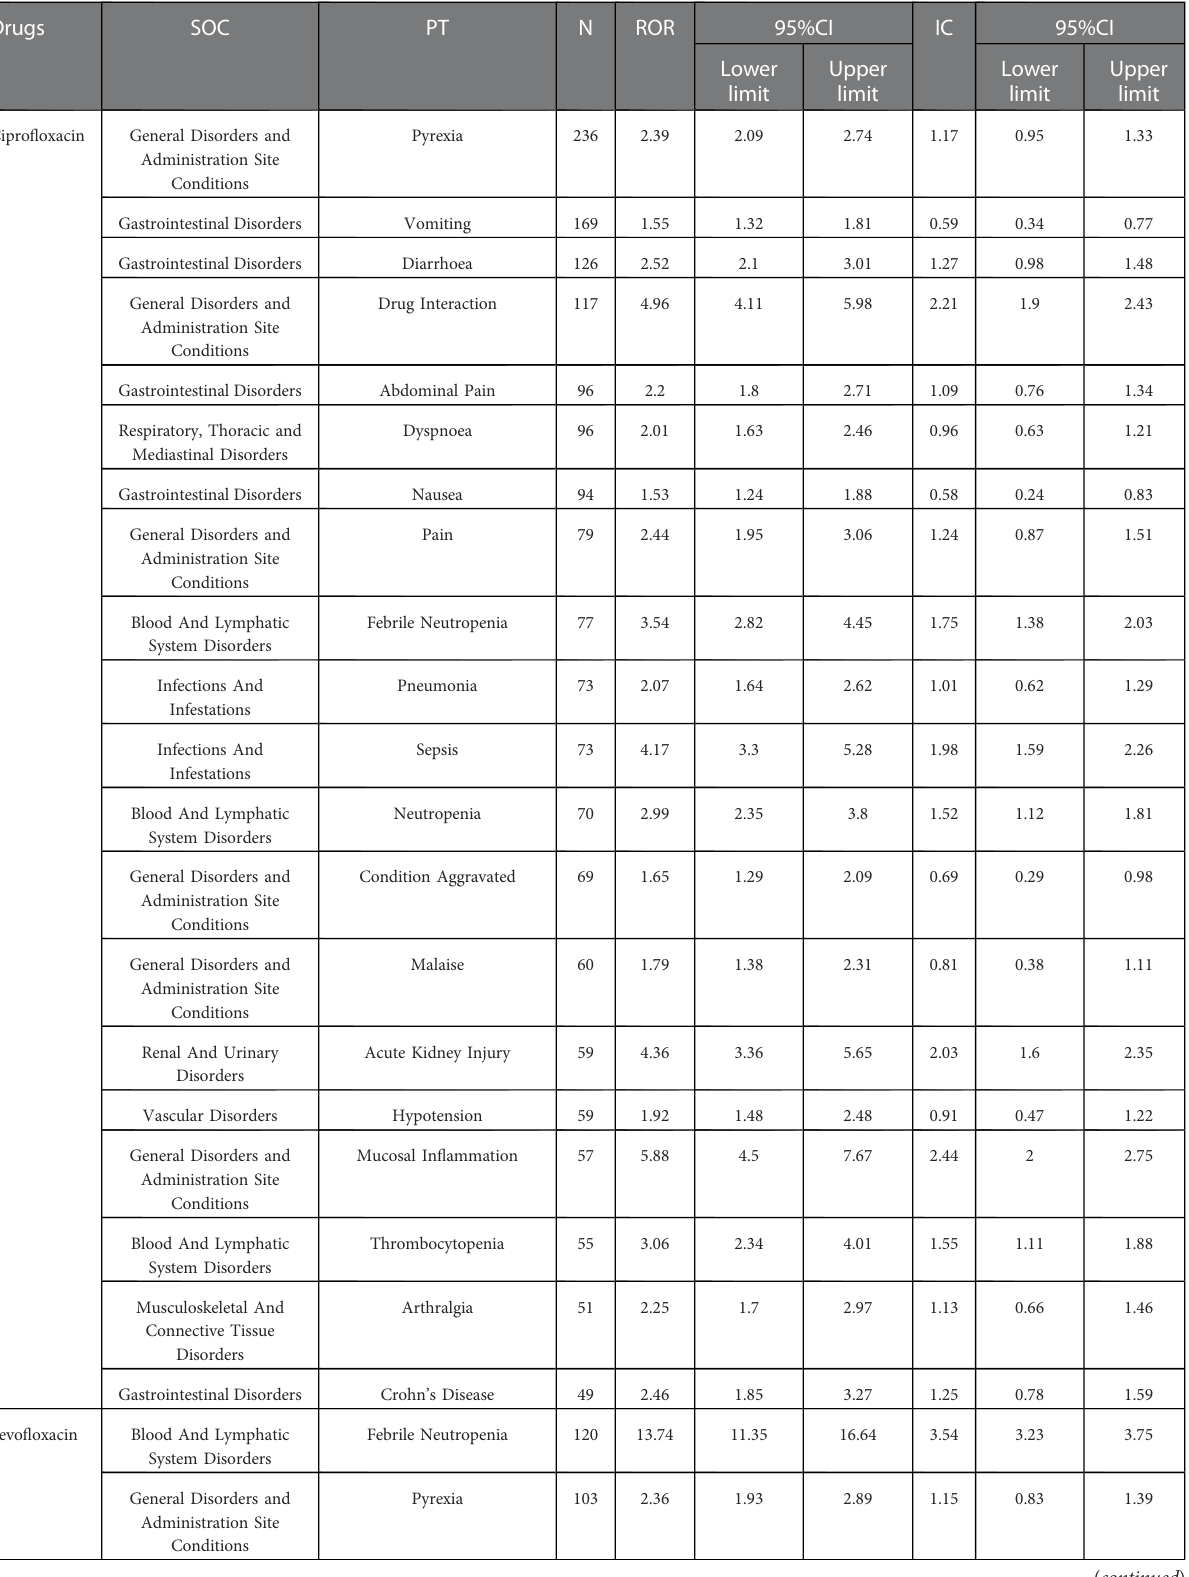
TABLE 2 Signal strength for the top 20 most frequently AEs with quinolones at PT level in FAERS. Drugs SOC PT N ROR 95%CI